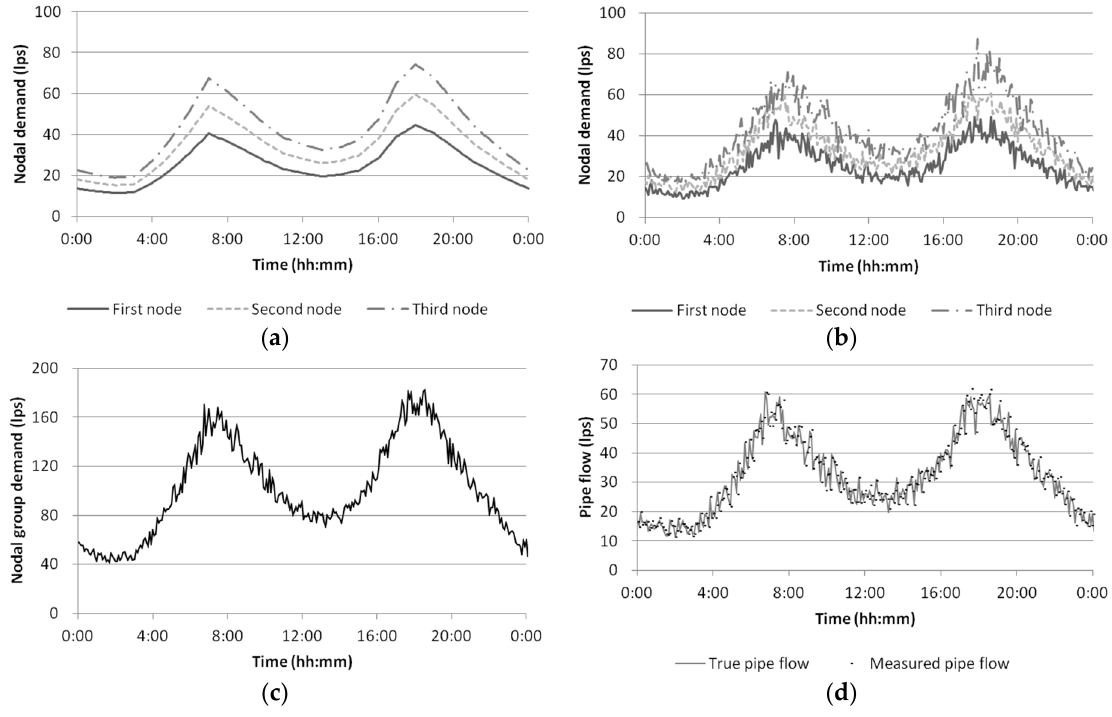
Figure 5. Synthetic field measurement generation steps: ( a ) an identical demand pattern (Residential 1) is assigned to each node ( i.e. , time-varying demand factors are multiplied by the base demand); ( b ) random variability is added to the nodal demands; ( c ) the true node group demand ( i.e. , the sum of the three nodes' demand generated in the previous step); and ( d ) the true pipe flow and the addition of measurement error.